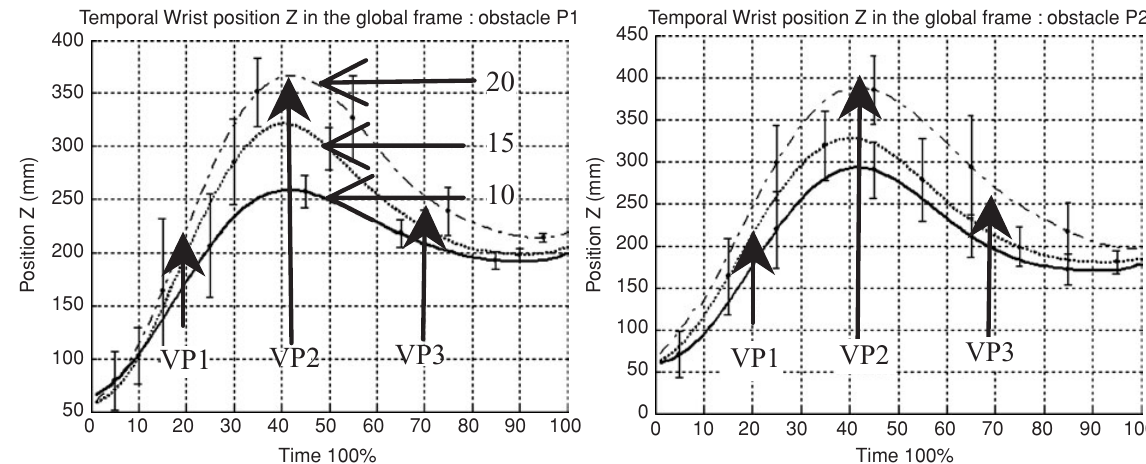
Figure 2 Temporal wrist elevation and via point specification.